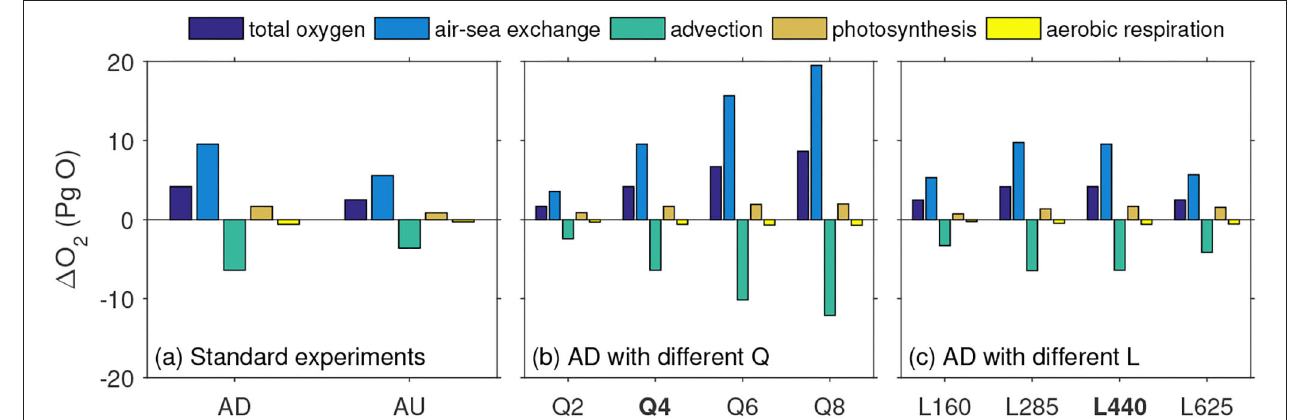
FIGURE 6 | Cumulative changes in the WSNP’s oxygen inventory in (a) the standard AD and AU simulations, (b) AD simulations with a downwelling rate of 2, 4, 6, 8 cm/day, and (c) AD simulations with a pipe length of 160, 285, 440, and 625 m. For each model run, the cumulative change in the oxygen inventory is split into different components (shown in the legend). All the components are integrated above 960 m within the WSNP region from year 2020 to